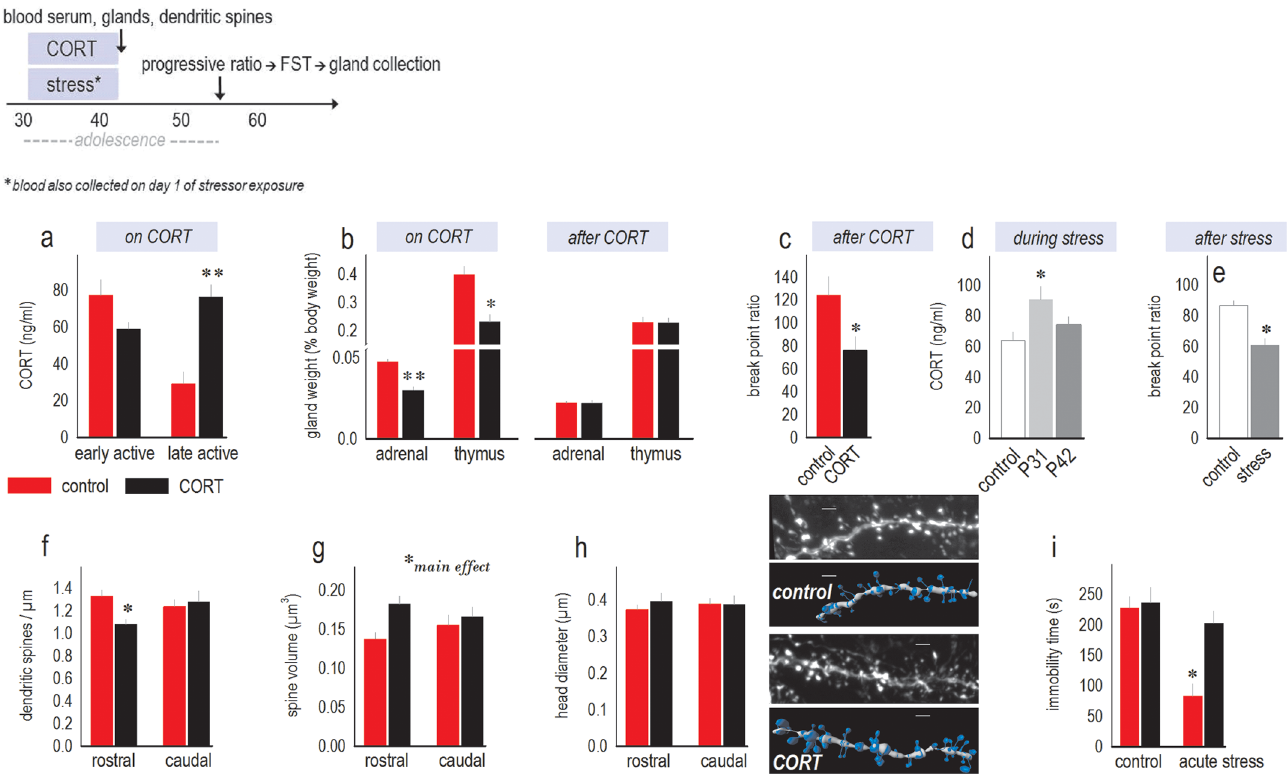
Fig 1. Effects of CORT exposure during adolescence: Validation of the procedure. Top: timelineof experimental events. See also Table 1. (a) Blood serum CORT levels at the end of an 11-d CORT exposureperiod(from P31–42)did not differ betweengroups at the beginningof the active cycle (followingsleep) but were elevatedin CORT-drinking mice (relative to control mice) at the end of the awake, active cycle. n = 5–10/group.(b) Adrenal and thymus gland weights also atrophiedfollowingexogenous CORT exposure (left), but glands recovered with a washoutperiod (right). n = 5–6/group. (c) In a progressive ratio test, a history of CORT exposurereducedbreak point ratios. n = 5–6/group.(d) Forced swim stress in adolescence also increasedblood serum CORT (though this effect appeared to habituatewith repeatedexposure). n = 5–11/group. (e) Further, break point ratios were also reduced, as with CORT exposure. n = 5–10/group. (f) CORT exposure from P31–42also eliminated dendriticspines on excitatory neuronsin the anterior mPFC (prelimbic subregion)of thy1 -YFP expressingtransgenicmice. n = 7 mice/group. (g) CORT increasedoverall spine volume. (h) Dendriticspine head diameterdid not, however,change.Representative dendrites are adjacent (unprocessed image at top, followed by reconstruction). (i) Finally, in the forced swim test, a history of subchronic CORT exposuredid not impact mobility but modifiedreactivity to an acute stressor: Acute stress inducedmobility in control mice, but mice with a history of CORT exposure remained immobile. n = 5–7/group. * p (cid:20) 0.05, ** p < 0.001 compared to control (red or white bars). Scale bar = 2 μ m. Raw data for this figure can be found in S1 Data. CORT, corticosterone; FST, forced swim test; mPFC, medial prefrontalcortex; P, postnatalday; YFP, yellow fluorescent protein.